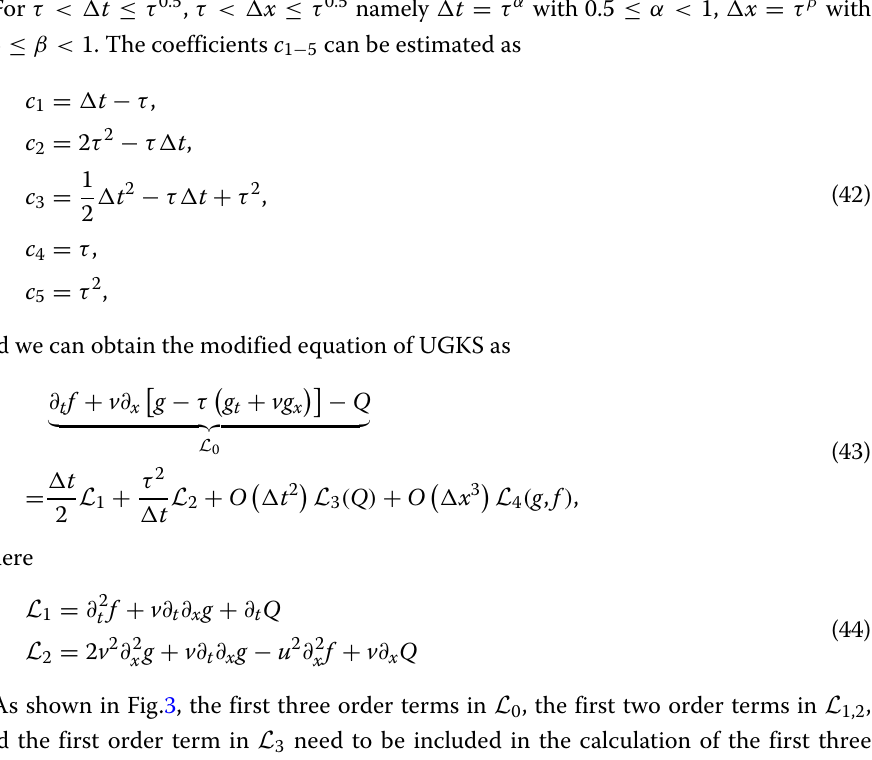
For τ < (cid:4) t ≤ τ 0.5 , τ < (cid:4) x ≤ τ 0.5 namely (cid:4) t = τ α with 0.5 ≤ α < 1, (cid:4) x = τ β